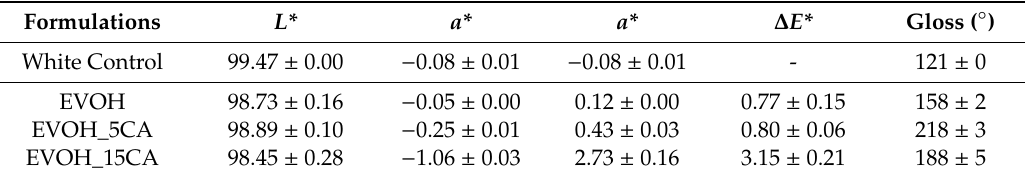
(Figure 3, graphs and visual images). The highest ∆ E * value for EVOH films has been obtained for EVOH_15CA film ( ∆ E * = 3.15 ± 0.21). Table 1. Colour coordinates of EVOH based systems. Table 1 . Colour coordinates of EVOH based systems.